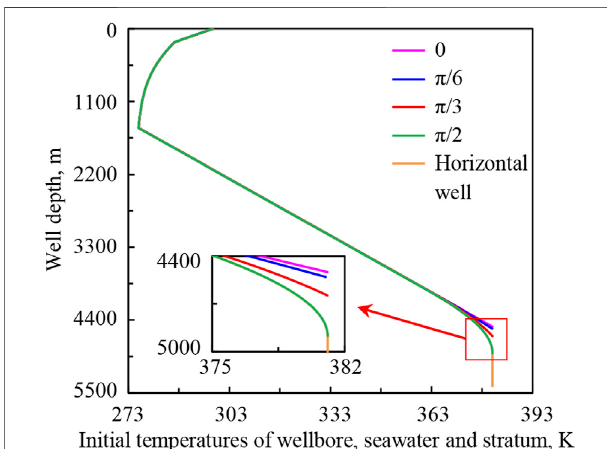
FIGURE 17 | Initial temperature distribution of wellbore, seawater, and stratum under different hole deviation angles.